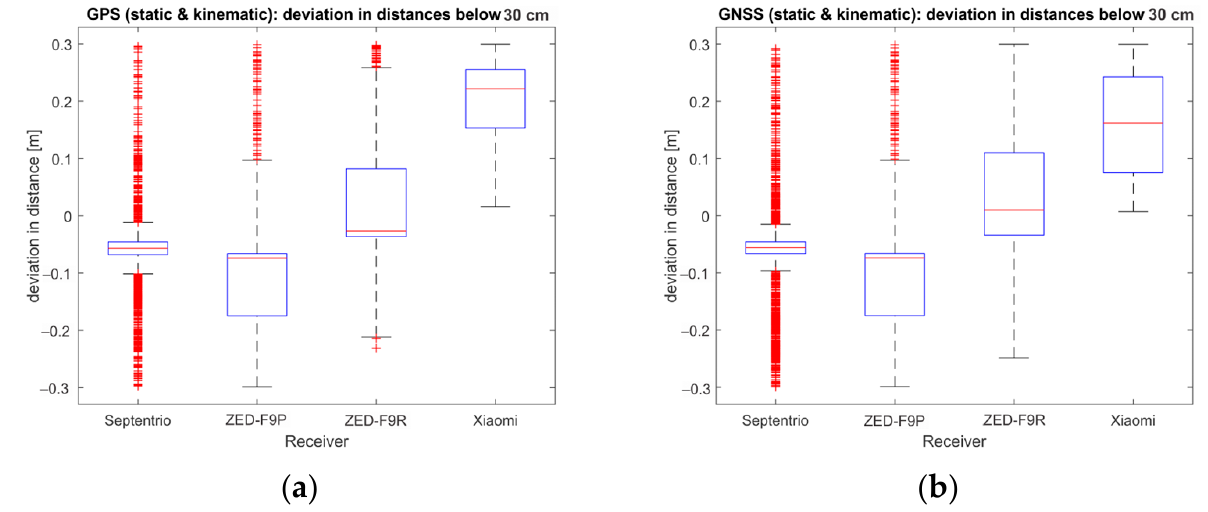
Figure 9. Boxplot for deviation of horizontal distances below 30 cm: ( a ) GPS solution; ( b ) GNSS solution. Table 7. F -test ( α = 5%) for deviations in distances of less than 30 cm; comparison between GPS and GNSS solutions for each of the receivers.